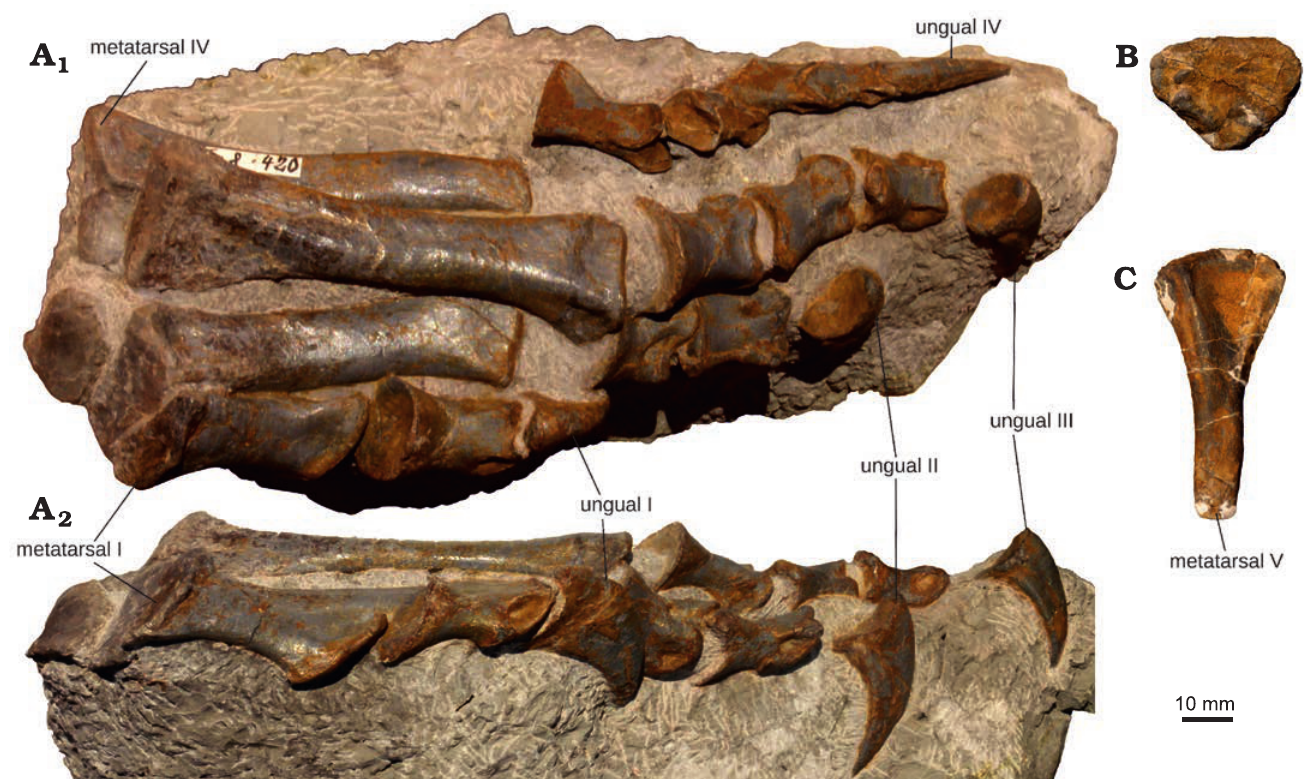
Fig. 12. Pes of juvenile Plateosaurus cf. trossingensis Fraas, 1913 skeleton MSF 15.8B. from the Norian of Frick, Switzerland. A . Left pes, MSF 15.8.2019, in dorsal (A 1 ) and medial (A 2 ) views. B . Distal tarsal III or IV, MSF 15.8.823, in distal view. C . Right metatarsal V, MSF 15.8.826, in dorsal (anterior)